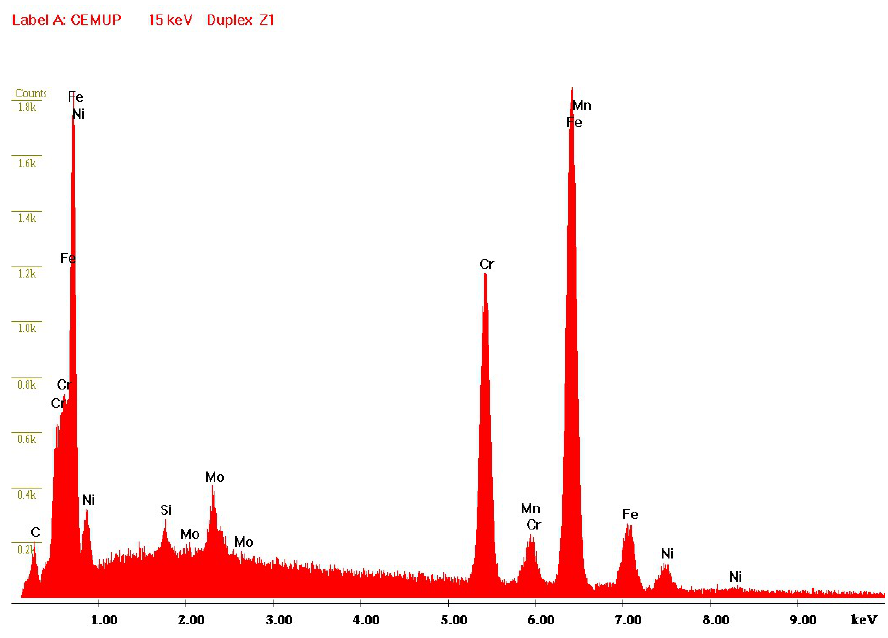
Figure A4. EDS of the red zone in the first Duplex 14462 SEM image.